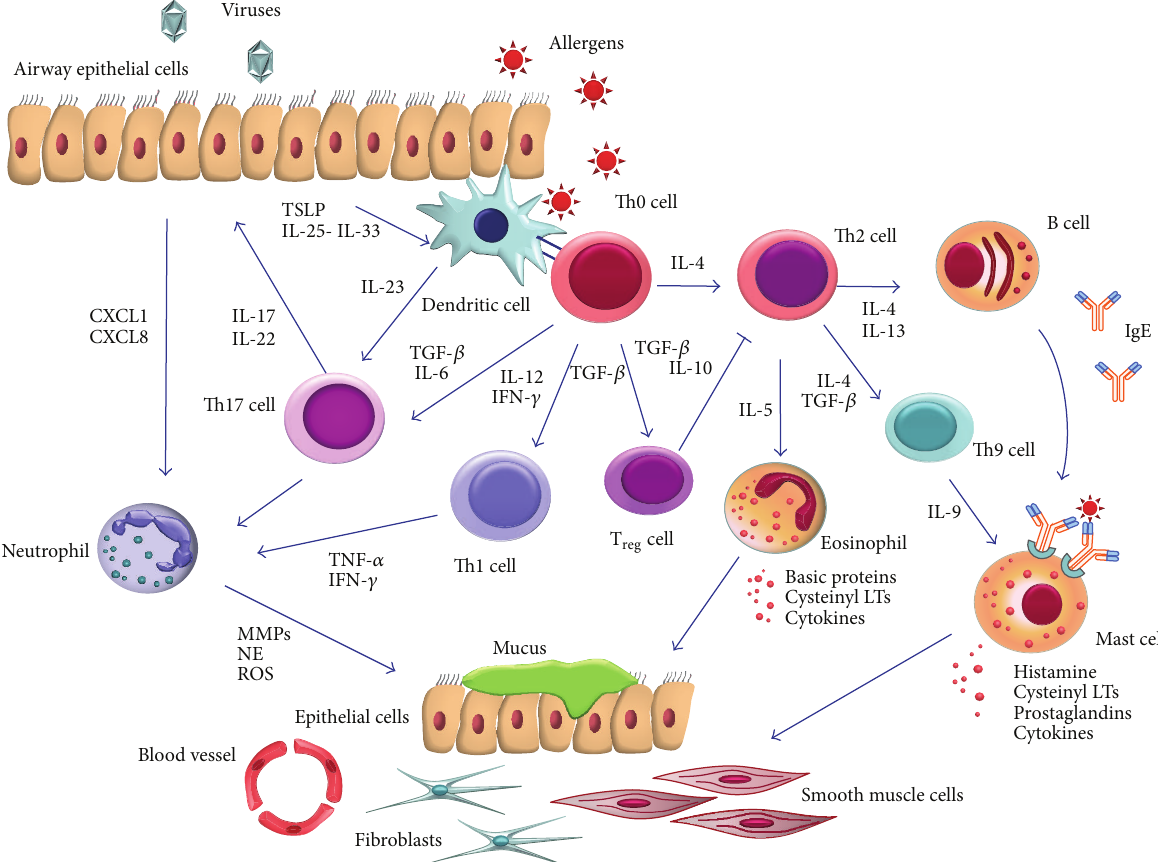
Figure 1: Pathobiology of airway inflammation in asthma. Asthma originates from complex interactions between genetic factors and environmental agents such as aeroallergens and respiratory viruses. In particular, within the airway lumen allergens can be captured by dendritic cells, which process antigenic molecules and present them to na¨ıve (Th0) T helper cells. The consequent activation of allergen- specific Th2 cells is responsible for the production of IL-4 and IL-13 that promote B-cell operated synthesis of IgE antibodies; moreover, Th2 cells also release IL-5, which induces eosinophil maturation and survival. These events are noticeably favoured by a functional defect of IL-10/TGF- 𝛽 producing T regulatory (Treg) cells that normally exert an immunosuppressive action on Th2 cell-mediated responses. In addition to Th2 cells, IL-9 releasing Th9 cells can also undergo activation, thus leading to the growth and recruitment of mast cells, which upon IgE-dependent degranulation release both preformed and newly synthesized mediators. Other important T lymphocytes contributing to asthma pathobiology are Th17 cells, producing IL17A and IL-17F which cause neutrophil recruitment and expansion. Furthermore, IL-12- dependent and IFN- 𝛾 releasing Th1 cells can be activated, especially as a result of airway infections sustained by respiratory viruses. Finally, many mediators, cytokines, and growth factors produced by several different cells involved in chronic asthmatic inflammation may also affect the functions and proliferation rates of airway structural cellular elements including epithelial cells, fibroblasts, smooth muscle cells, and endothelial vascular cells. See text for further